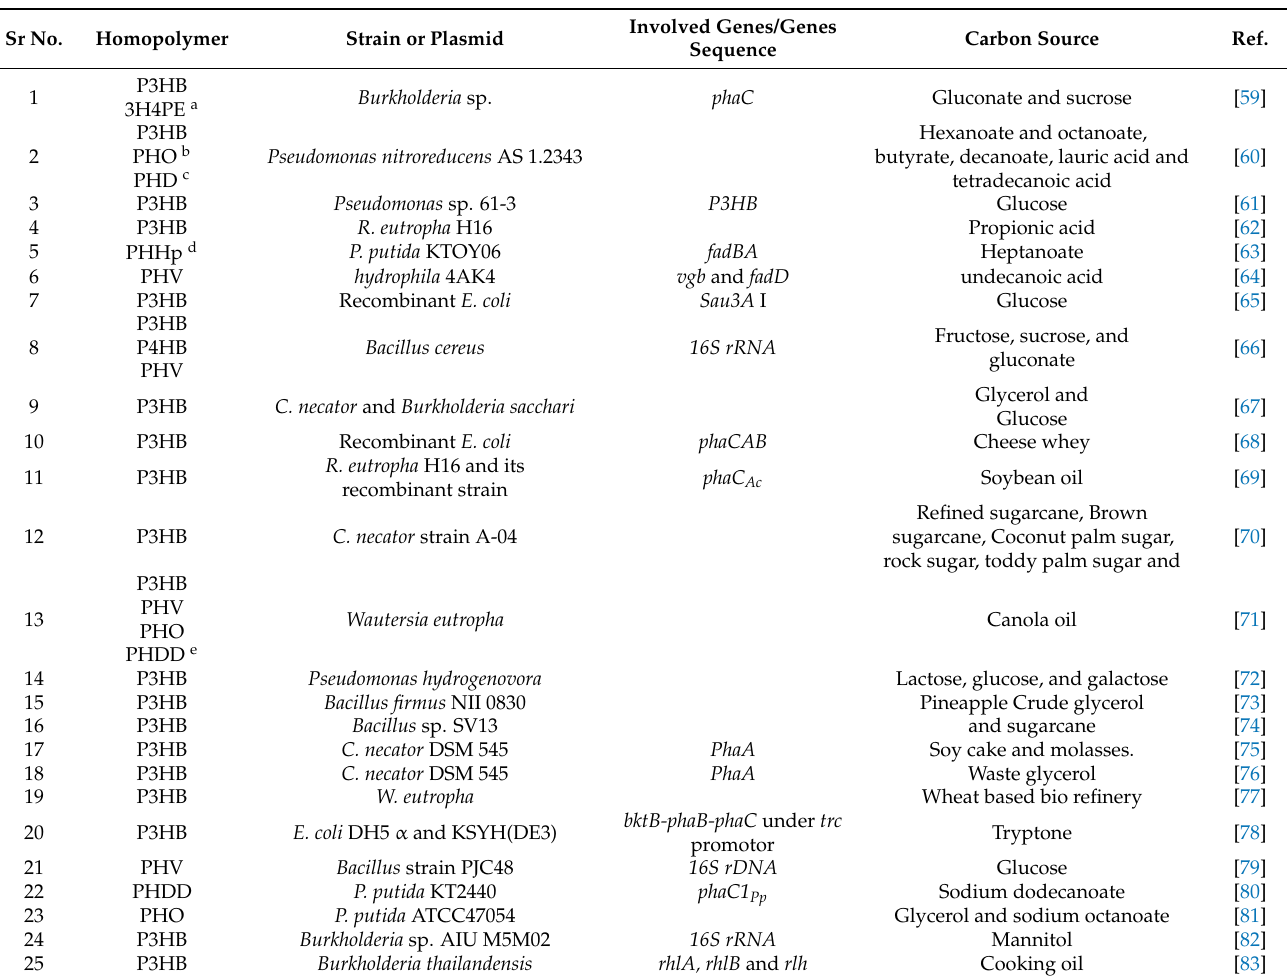
Table 3. Microbial production of PHAs